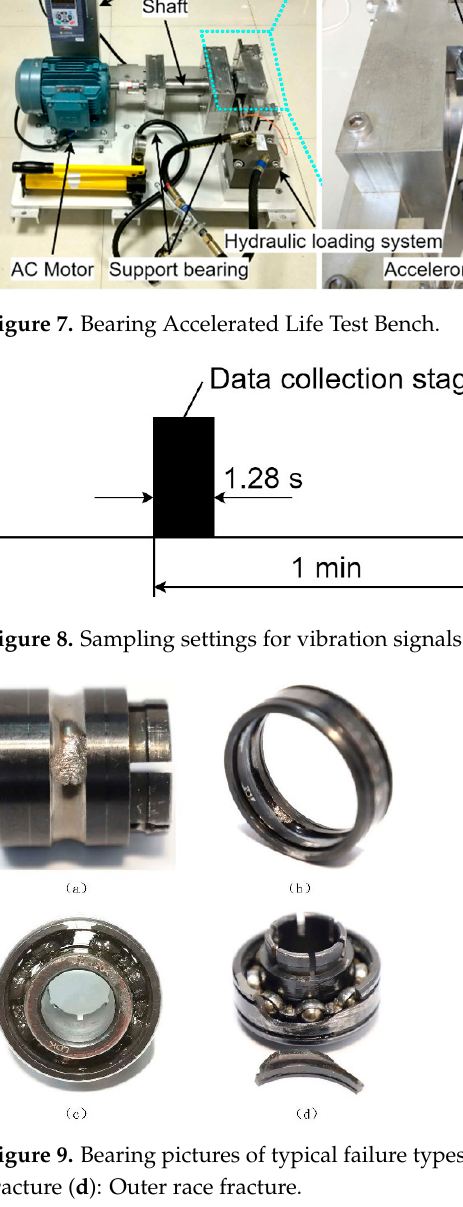
Figure 7. Bearing Accelerated Life Test Bench.